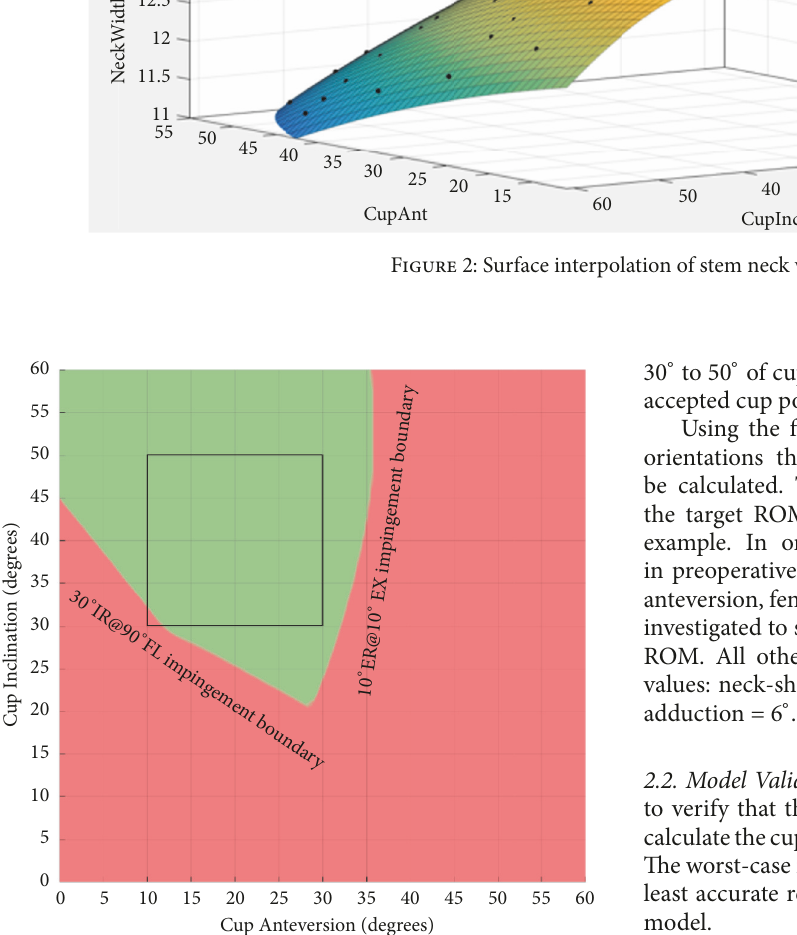
testing condition of 30 ∘ IR@90 ∘ FL and 10 ∘ ER@10 ∘ EX. The diagonal curve represents the 30 boundary. Cup orientations on the left-hand side of this boundary are at risk of prosthetic impingement in flexion. boundary. Cup orientations on the right-hand side